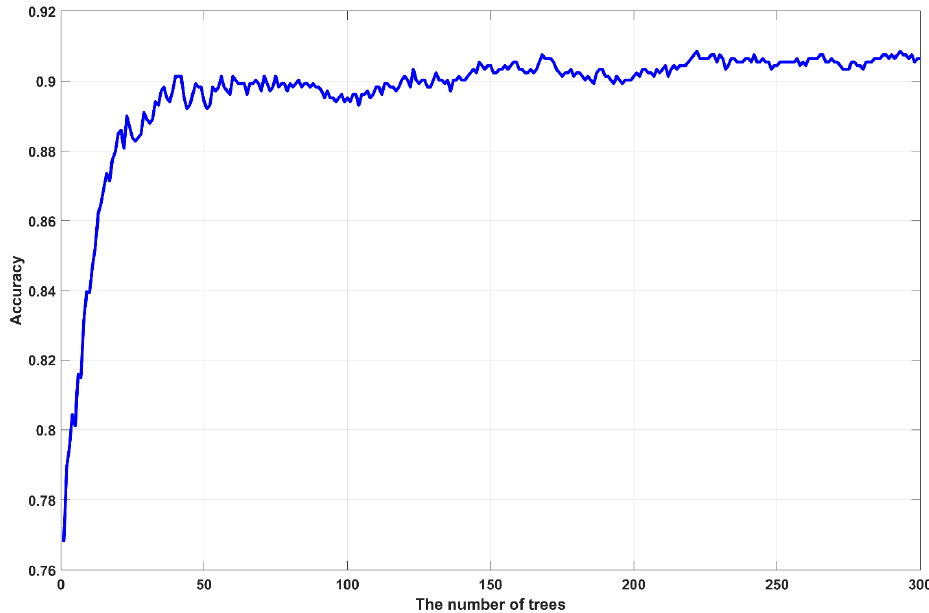
Figure 7. The identification accuracies with different number of trees in random forest.